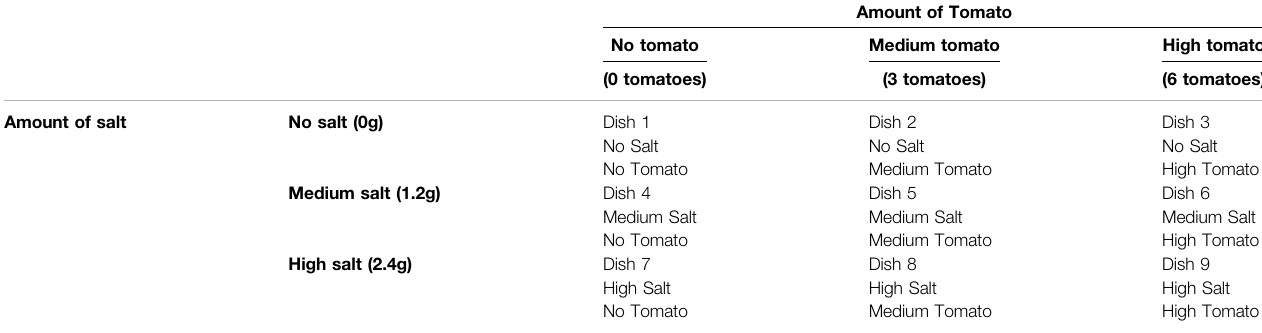
TABLE 2 | Table showing composition of 9 dishes used in classi fi cation experiment. The listed ingredients are combined with 6 large eggs to make a tomato